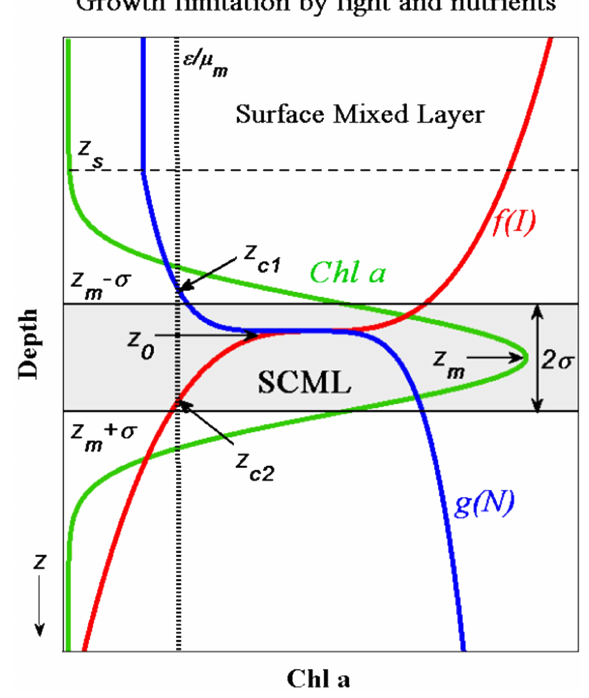
Figure 1. Schematic picture of Chl a distribution under the limi- tation by light and nutrient in stratified water columns (green solid line is Chl a concentration as a function of depth; red solid line is the growth-limiting term with respect to light, f (I) ; blue solid line is the growth-limiting term with respect to nutrients, g(N) ; horizontal dashed line represents the depth of surface mixed layer, z s ; horizon- tal solid lines indicate the locations of the upper and lower SCML, z m − σ and z m + σ , respectively; vertical dotted line is the ratio of loss rate to maximum growth rate, ε/µ m ; z c 1 and z c2 refer to the two compensation depths where µ m g(N) = ε and µ m f (I) = ε , re- spectively; z 0 and z m indicate the depths of maximum in growth rates and in Chl a concentrations, respectively; and double arrow represents the thickness of the SCML, 2 σ)